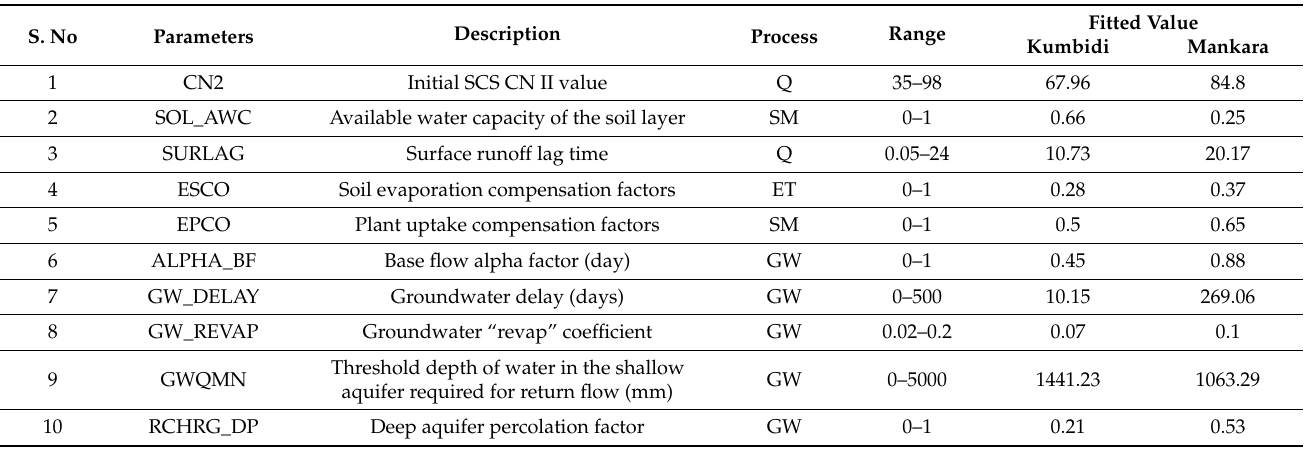
Table 4. SWAT parameters, description, range, and the fitted values used during calibration at Mankara and Kumbidi gauging stations.